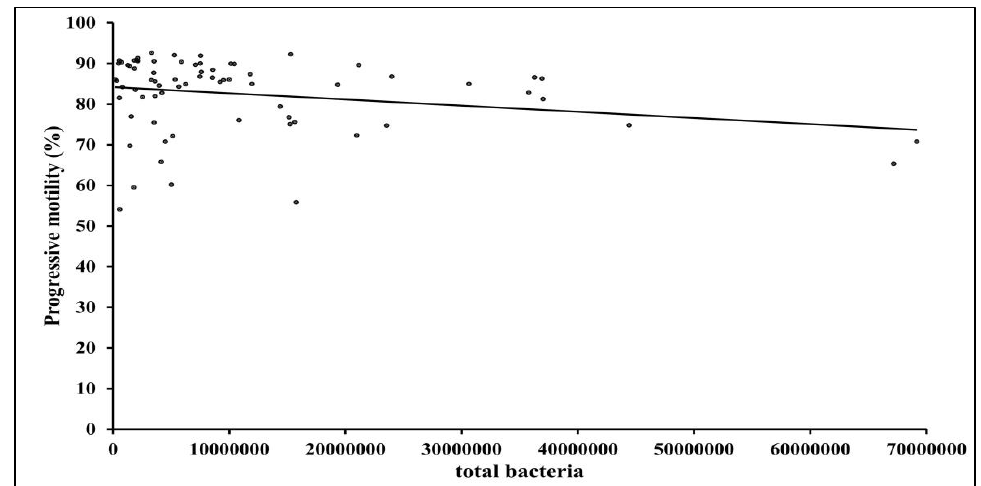
Figure 6. Correlation between total bacterial colony counts per sample and progressive motility at 0 h (r = −0.24; P < 0.05).